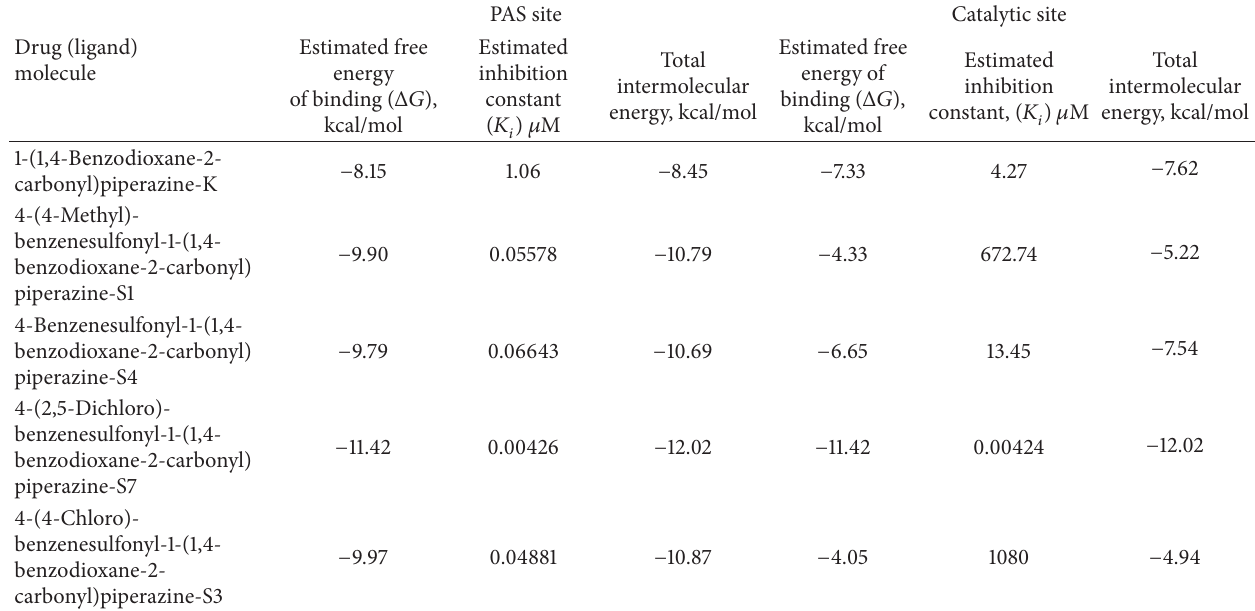
Table 2: Comparisons of free energy of binding and inhibition constants of the derivatives on both PAS and catalytic site.